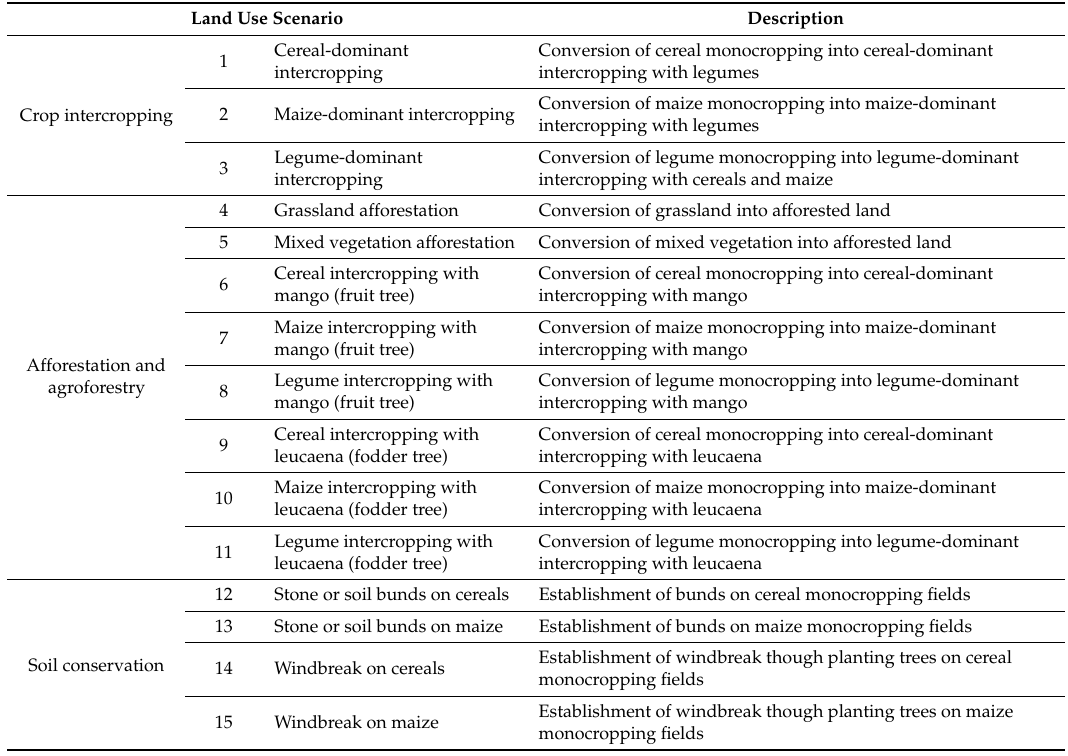
Table 3. Locally feasible land use scenarios and their